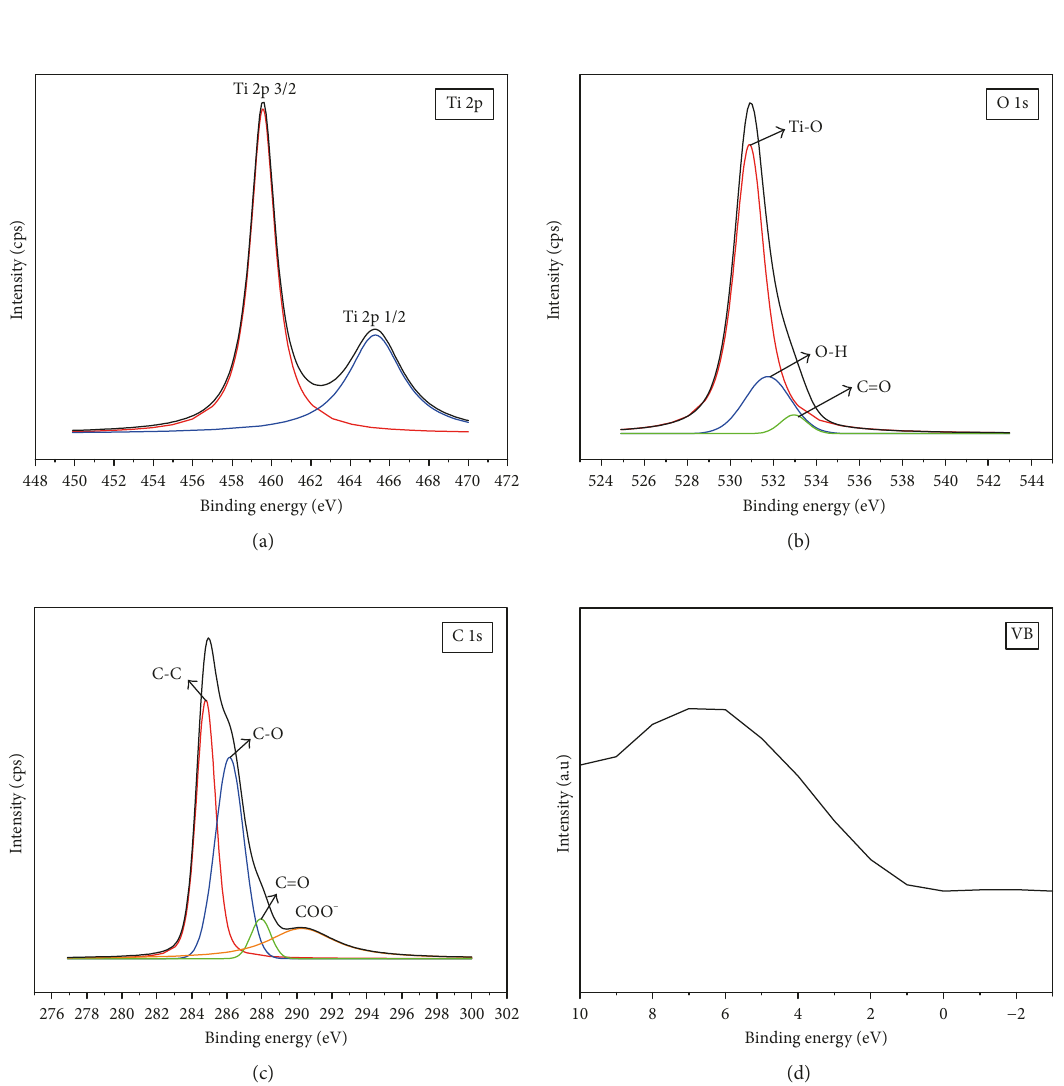
Figure 5: High-resolution XPS spectra of (a) Ti 2p, (b) O 1s, (c) C 1s, and (d) XPS valence band for TiO cycles after calcination at 1000 °